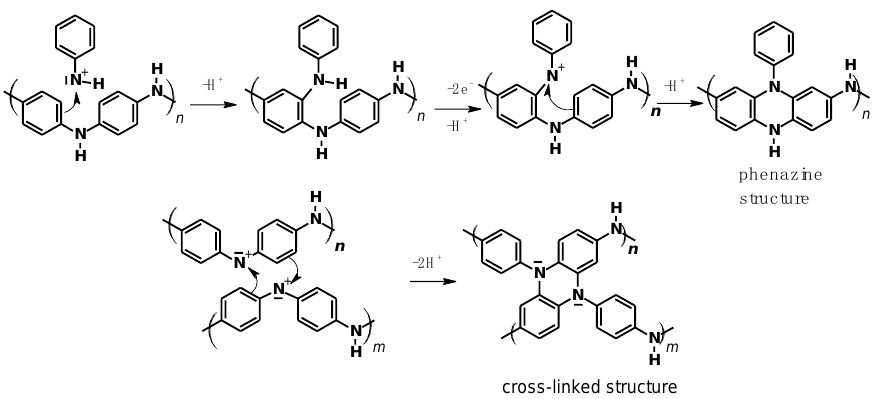
Figure 6. The reactions of polyaniline during oxidation leading to the formation of phenazine structures and cross-linked structures [36].